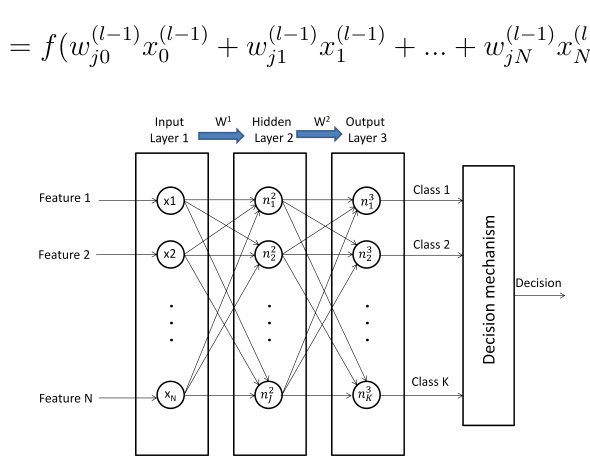
Figure 2. Basic architecture of an NN for